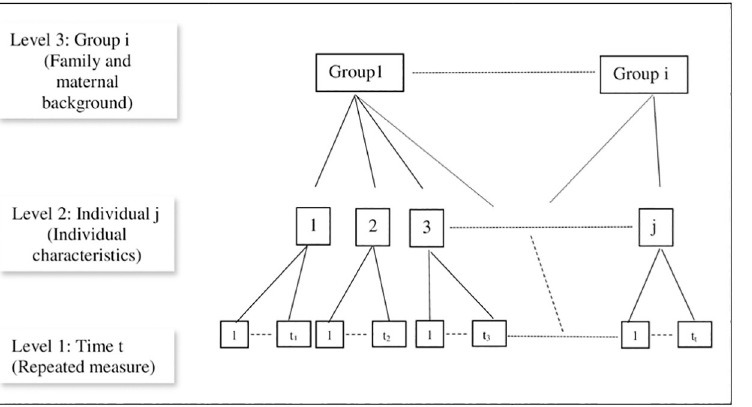
Fig 2. Repeated measure three level data